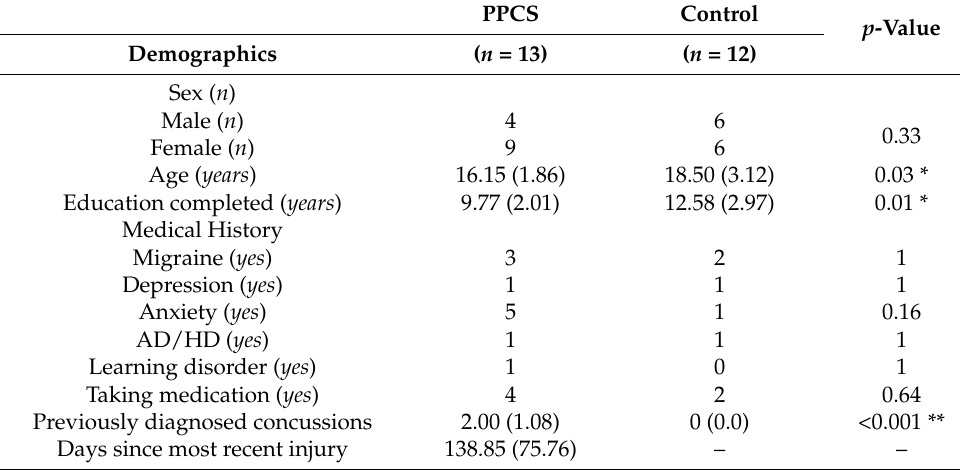
Table 1. Demographic information and injury characteristics by group.